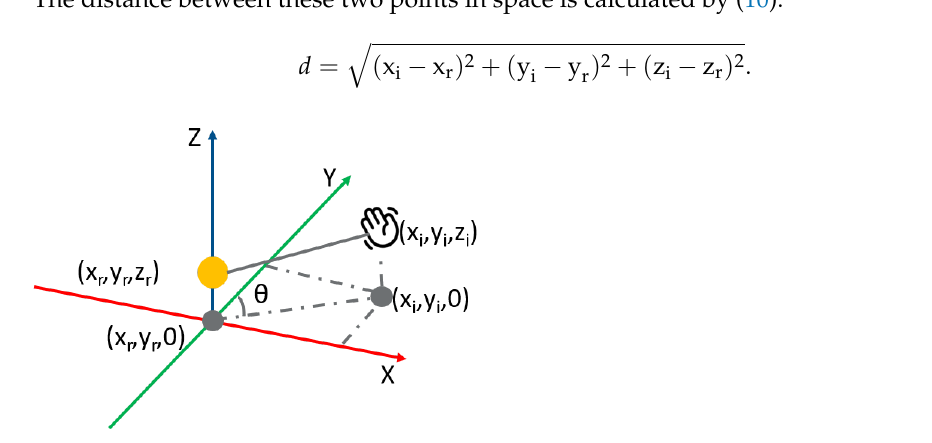
Figure 7. Target and radar in the coordinate